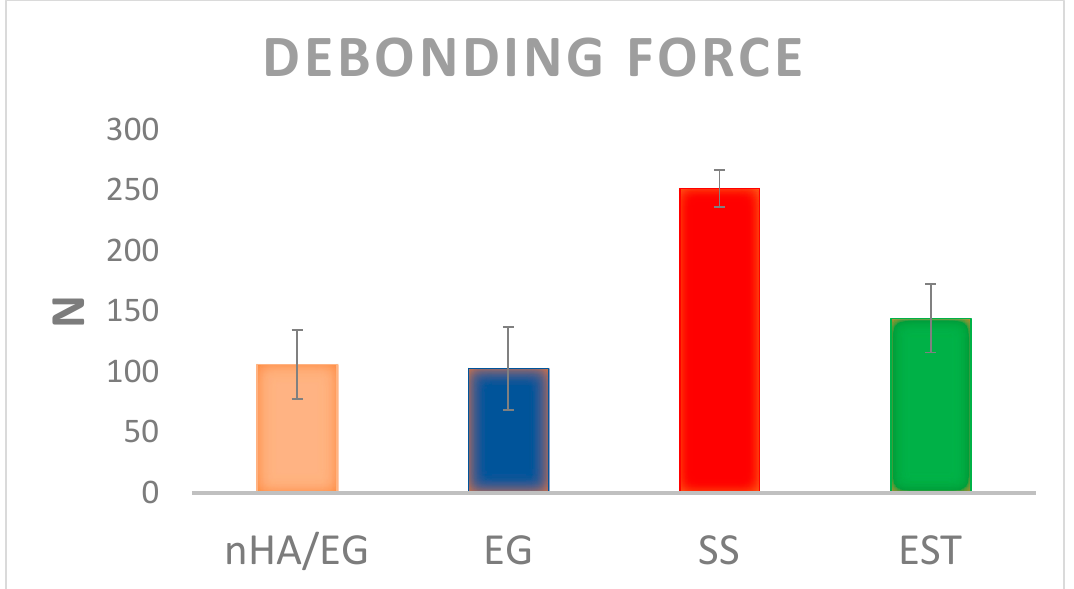
Figure 3. Mean and standard deviation of the debonding force of bonded control and experimental lingual retainers.